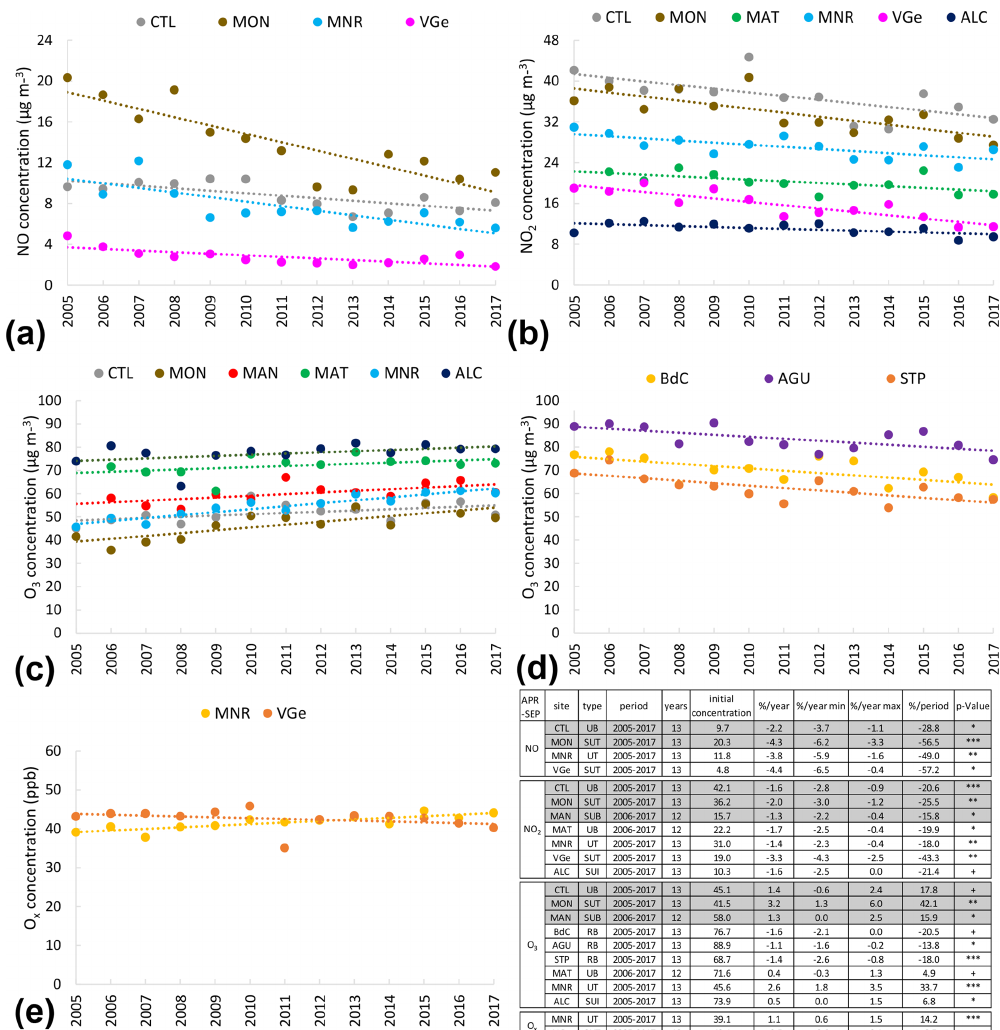
Figure 4. Results of the time trend assessment carried out for annual season averages (April–September) of NO (a) , NO 2 (b) , O 3 (c, d) and O x (e) levels using the Theil–Sen statistical estimator shown graphically. Only the trends with statistical significance are shown. (d) Numeri- cal results; the symbols shown for the p values relate to how statistically significant the trend estimate is: p < 0 . 001 ∗∗∗ = (highest statistical significance), p < 0 . 01 = ∗∗ (mid), p < 0 . 05 = ∗ (moderate), and p < 0 . 1 = + (low). No symbol means lack of a significant trend. Units are µgm − 3 . Shaded air quality monitoring sites belong to the S–N axis. Types of air quality monitoring sites are urban (traffic or background: UT, UB), suburban (traffic, industrial or background: SUT, SUI, SUB) and rural (background: RB). Data from AQ stations with at least 10 years of valid data within the